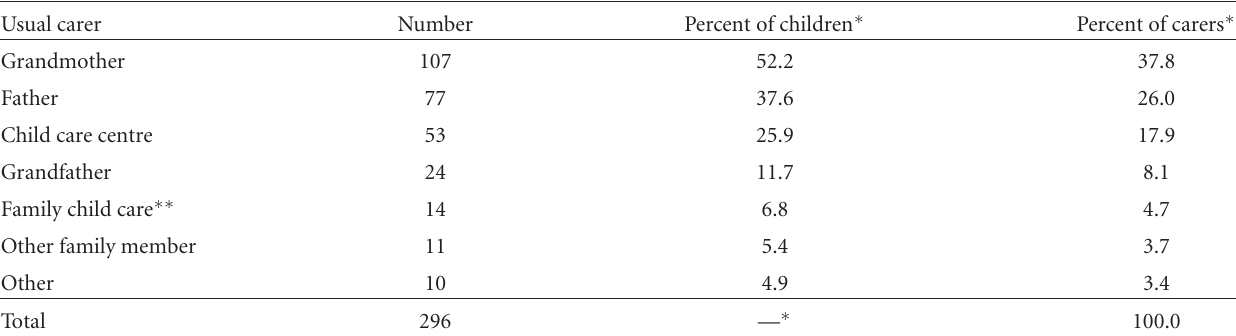
Table 3: Usual carer for the child during mother’s absence at work ∗